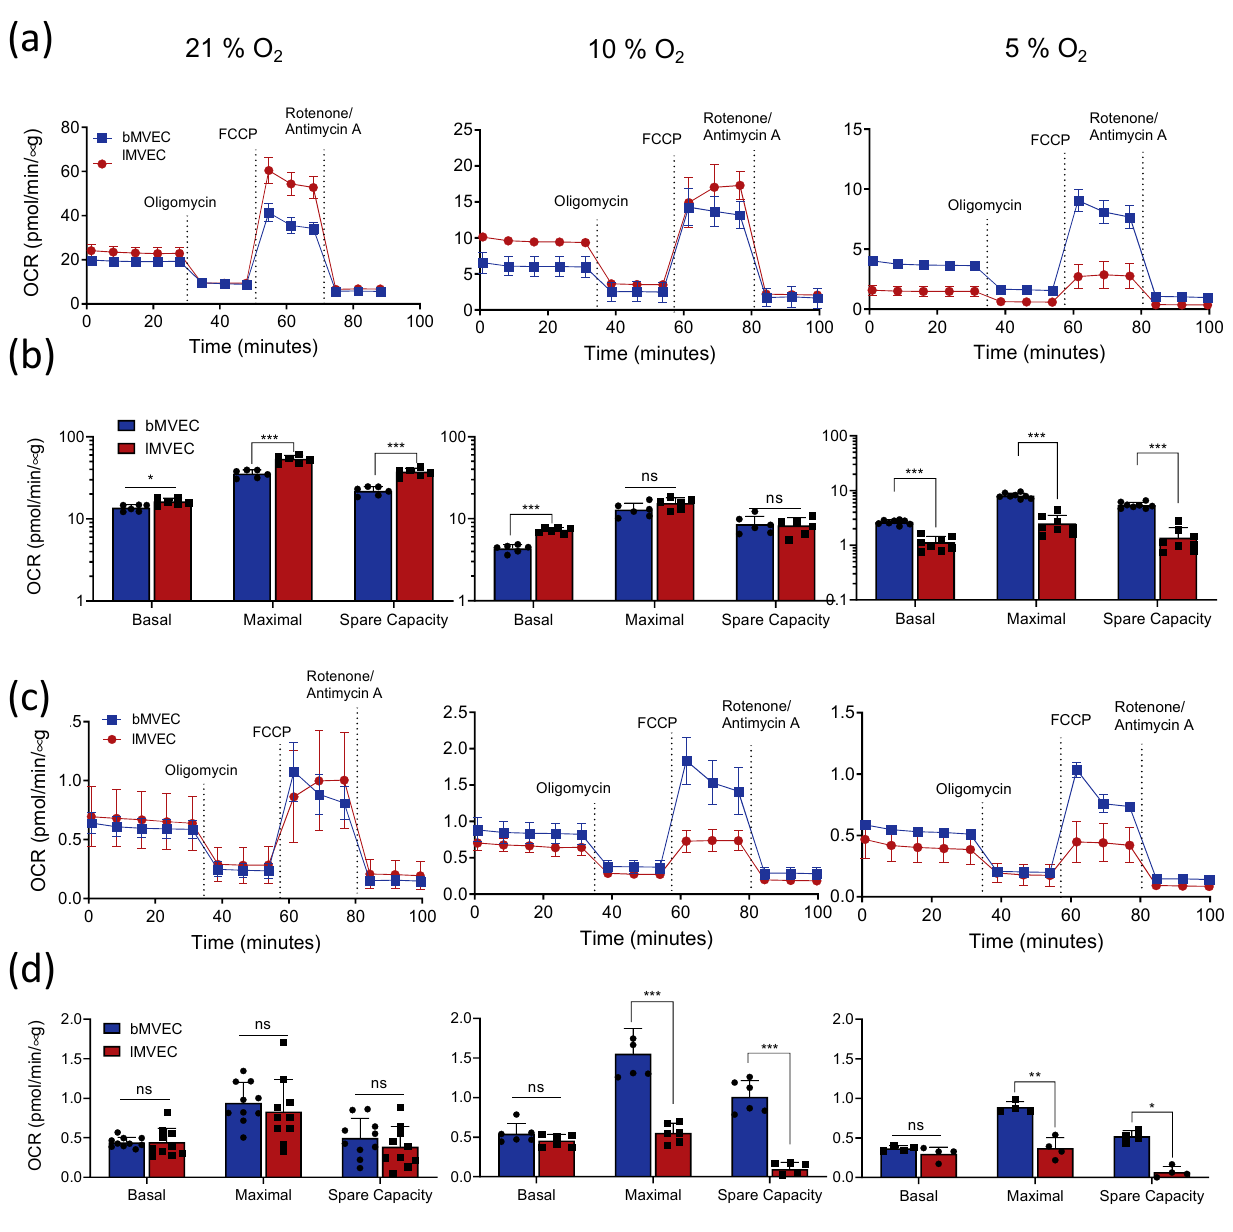
Figure 5. Mitochondrial metabolism of MVEC at baseline and after hypoxia is conditioned by oxygen priming and organ of origin. ( a ) Representative charts of mitochondrial function at baseline, in MVEC cultured at different O 2 (21%, left, 10% O 2 middle or 5% O 2 right); ( b ) mitochondrial metabolic parameters were calculated from each curve from ( a ). Data are shown as average ± SD ( n ≥ 4), statistical analysis was done using multiple t-tests with Holm–Sidak’s multiple comparison test (* p < 0.05, ** p < 0.01, *** p < 0.001, ns = not significant); ( c ) representative charts of mitochondrial function after adaptation to hypoxia (1% O 2 for 24 h prior to start of the assay). Assays were carried out at 1% O 2 ; ( d ) mitochondrial metabolic parameters of assays carried out after hypoxia were calculated from each curve from ( c ). Data are shown as average ± SD ( n ≥ 4), Significance assessed with 2-way ANOVA with Holm–Sidak’s multiple comparison test (* p < 0.05, ** p < 0.01, *** p < 0.001, ns = not significant).